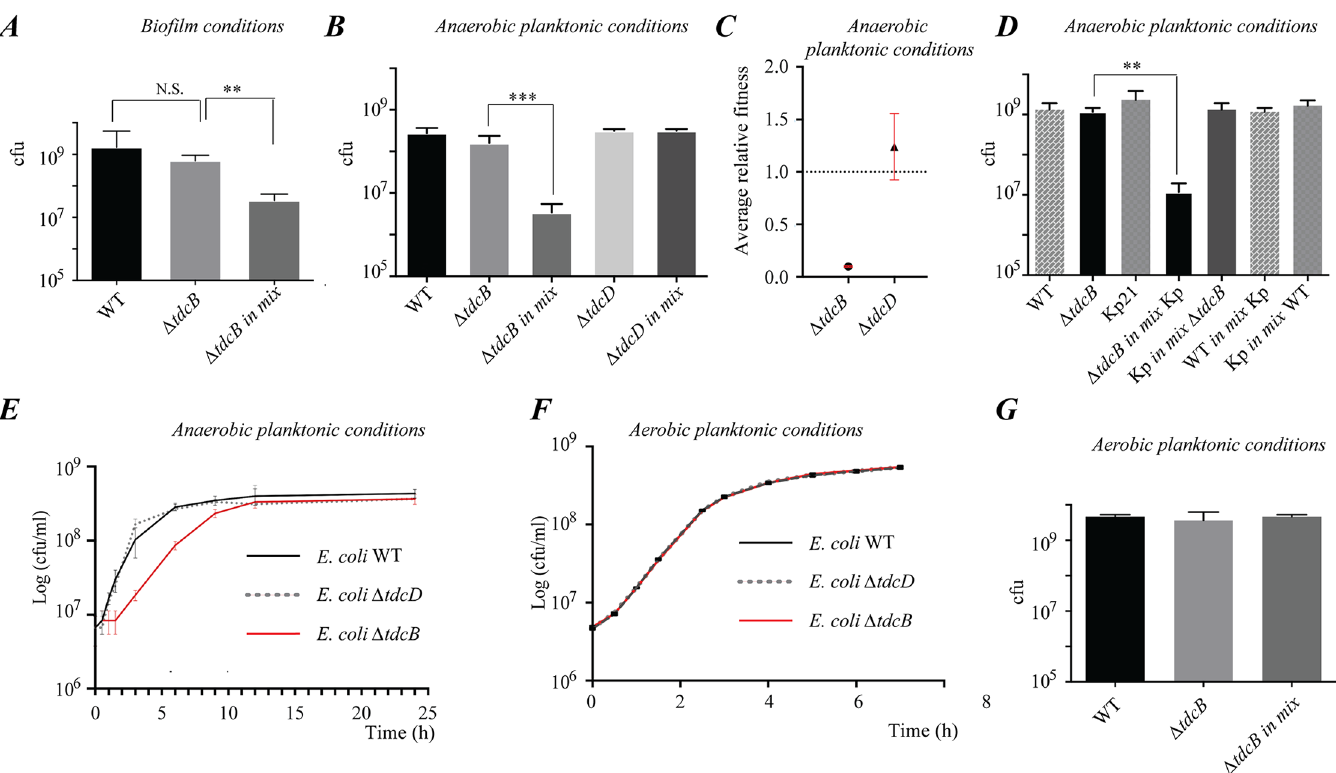
Fig 6. Impact of the E . coli 1-propanol pathway on fitness in biofilm or anaerobic planktonic competition experiments. ( A ) E . coli WT, and Δ tdcB mixed competition experiments performed in biofilm conditions. ( B ) E . coli WT, Δ tdcB and Δ tdcD mixed competition experiments performed in anaerobic planktonic conditions. ( C ) Comparisonof fitness of WT, Δ tdcB and Δ tdcD mutants in mixed competitionexperiments performed in anaerobicplanktonic conditions. Fitness was calculatedas describedin Materials and Methods. Dotted line represents WT fitness set to 1. ( D ) E . coli WT Δ tdcB and Klebsiella pneumoniae Kp21 mixed competitionexperiments performed in anaerobicplanktonic conditions. ( E ) E . coli Δ tdcB displaysan increasedgrowth lag comparedto WT or Δ tdcD mutant when grown in LB medium in anaerobicplanktonic conditions. The recovery of Δ tdcB mutant after 15H is unlikely to be due to the accumulationof adaptivemutations, since E . coli Δ tdcB growth lag is consistentlyobserved upon successive subcultures performed in triplicate in anaerobic planktonicconditions(S13 Fig). (F) Growth curves performed in aerobicplanktonicconditionsin LB medium, showing no lag or doublingtime difference between E . coli WT, Δ tdcB or Δ tdcD mutants. (G) Mixed competitionexperiments performed in aerobic planktonic conditions, showingno decreased fitness of a Δ tdcB mutant comparedto E . coli WT. Error bars represent standard deviations from triplicate samples.